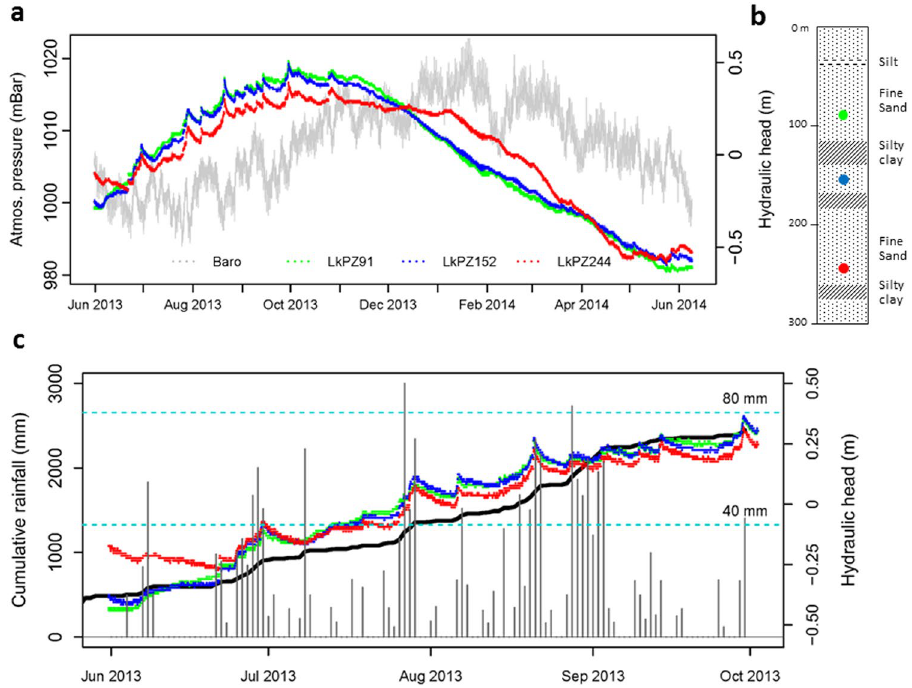
Figure 3. Hydraulic heads and rainfall at Laksmipur, June 2013 to June 2014. ( a ) The Laksmipur hydrographs at piezometers LkPZ91 (green, depth 91 m), LkPZ152 (blue, depth 152 m), LkPZ244 (red, depth 244 m) shown as equivalent fresh water head relative to the time series averages, and contemporaneous atmospheric pressure measured at the site; ( b ) the open screen measurement points of piezometers LkPZ91 (green), LkPZ152 (blue), and LkPZ244 (red) within the lithological profile; ( c ) daily rainfall (vertical bars, scale given as horizontal blue dashed lines) and cumulative rainfall (black line) superimposed on the hydraulic heads of LkPZ91, LkPZ152 and LkPZ244 as in ( a ). Note that the daily rainfall measurements are from a rain gauge 7 km distant from the Laksmipur multi-level piezometer site (Supplementary